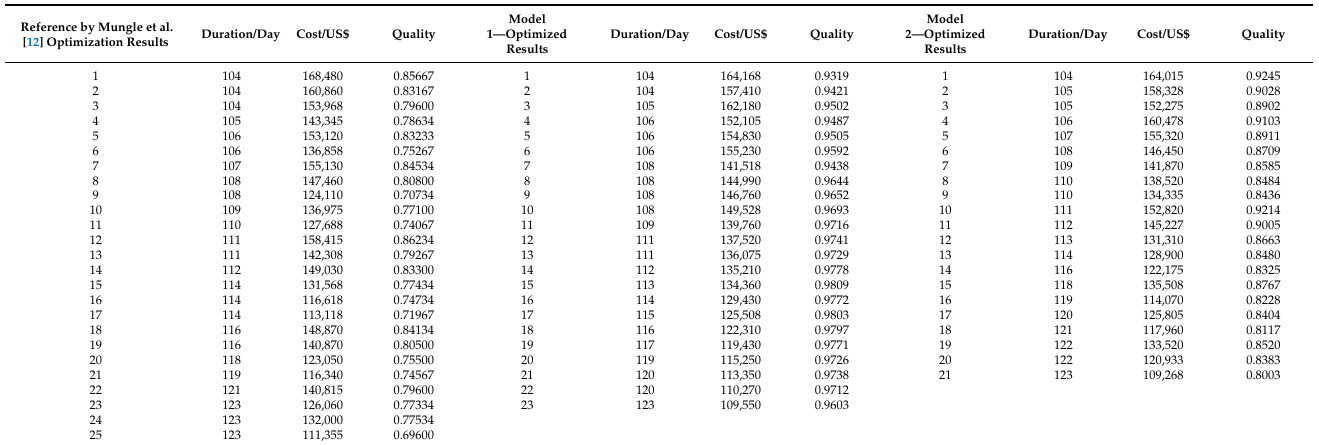
Table 3. Optimization results of literature by Mungle et al. [12] and optimization results of Models 1 and 2.